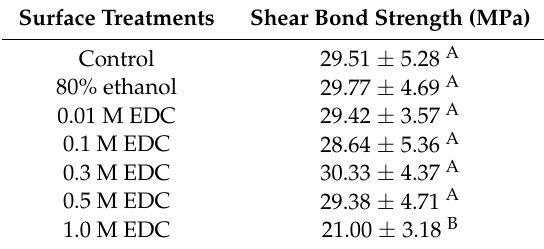
Table 1. Shear bond strength (MPa) of resin-dentin with different surface treatments (mean ± standard deviation).